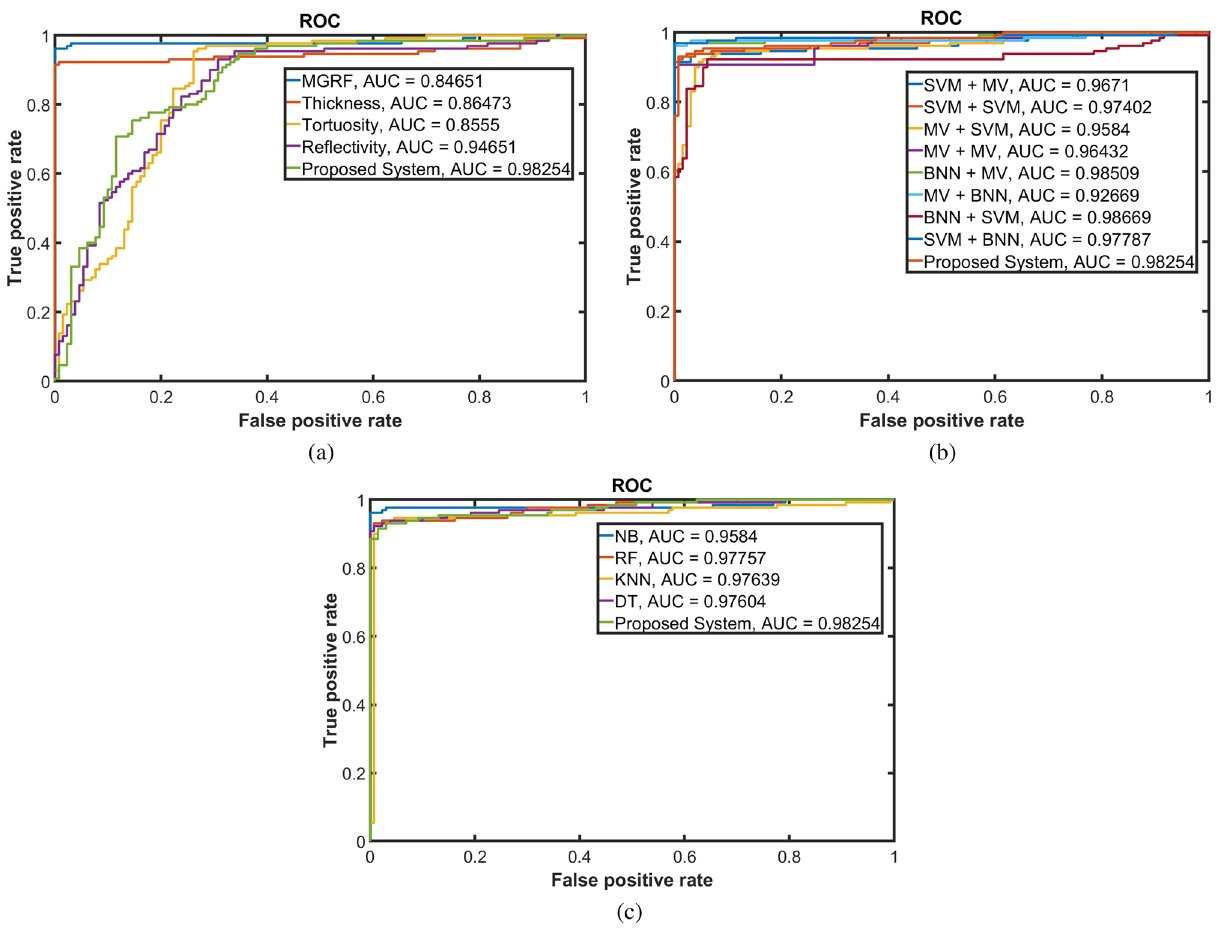
Figure 12. Receiver operating characteristic (ROC) curves of the developed system in comparison with classification obtained using ( a ) individual markers; ( b ) different fusion approaches; and ( c ) different statistical ML. The area under the ROC curve (AUC) of the proposed system is 98.25%